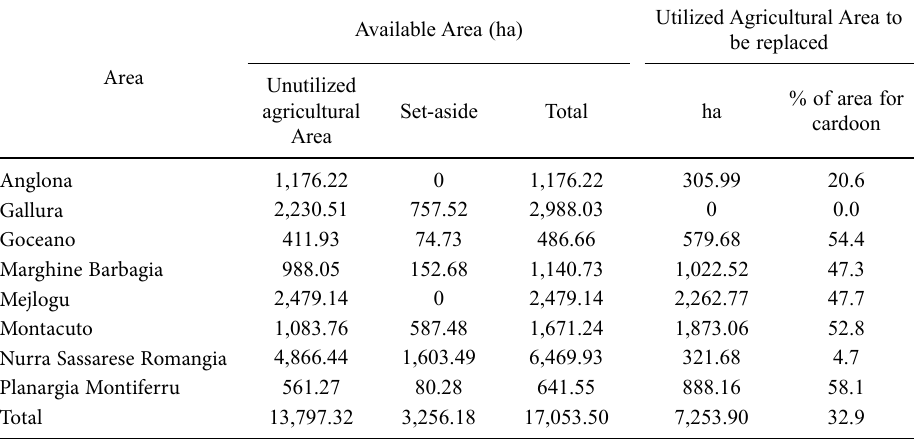
Utilized Agricultural Area to be replaced % of area for